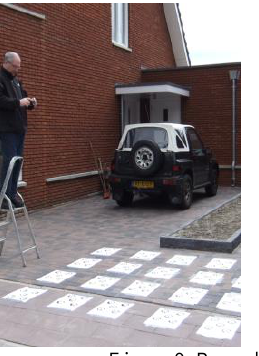
Figure 9: Procedure of the calibration of the